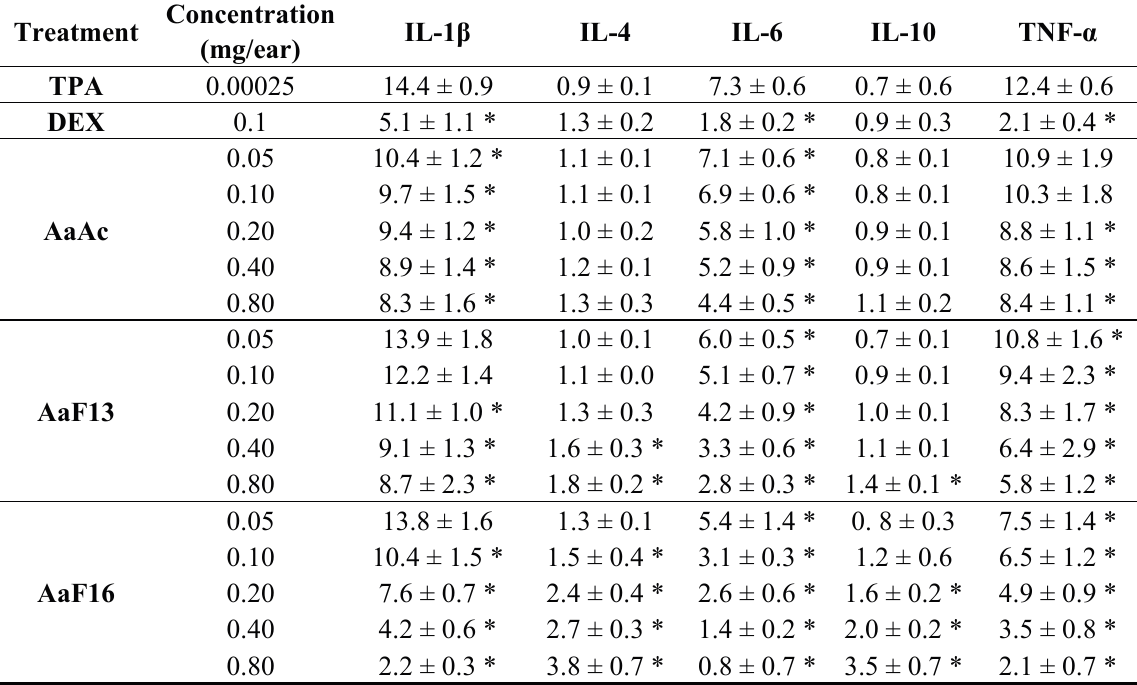
Table 1. Rate of increment of different cytokines concentration, in mouse ear with TPA.